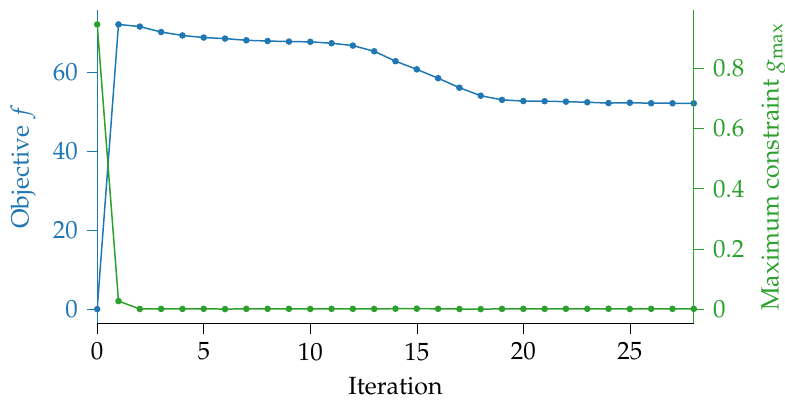
Figure 11. Convergence plot for the housing. Table 4. Optimization responses for the gear housing.